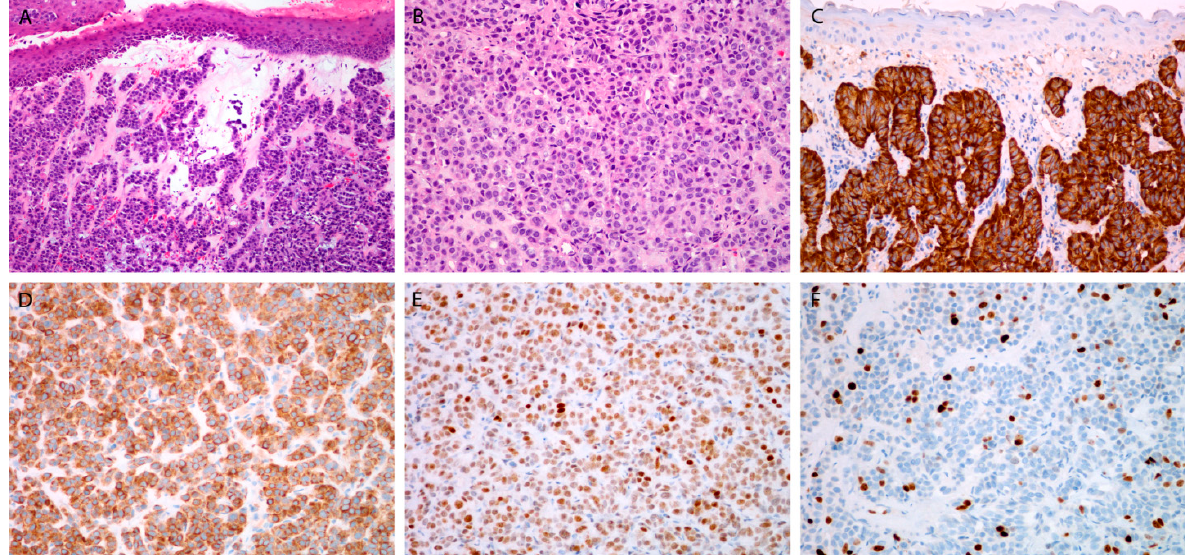
Figure 1. Moderately differentiated neuroendocrine carcinoma. Tumor beneath the surface epithelium, composed of uniform cell, with rare mitoses ( A , B ). Immunohistochemical staining for chromogranin ( C ), synaptophysin ( D ), INSM1 ( E ), and Ki-67 ( F ). Magnification 10 × 10 ( A , C ), 10 × 20 ( B , D – F ).